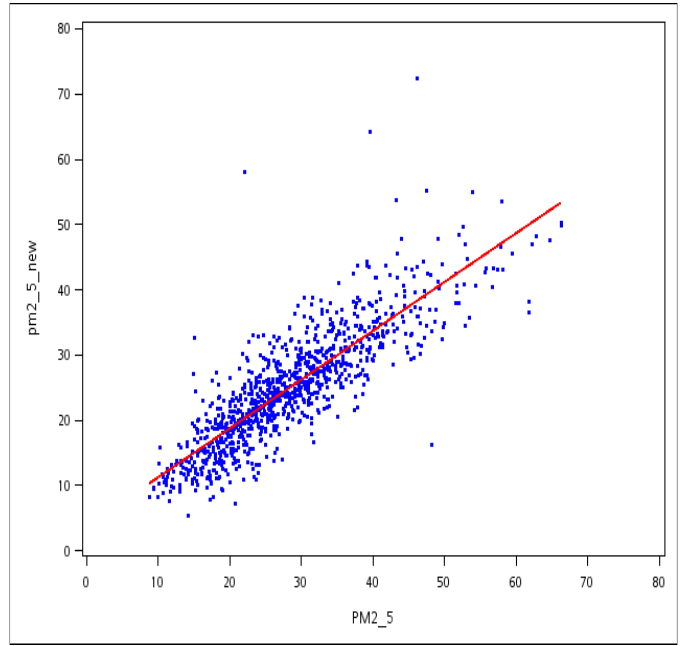
Figure A1. X -axis: land-use model, Y -axis: GIS (r = 0.85, n = 1003).